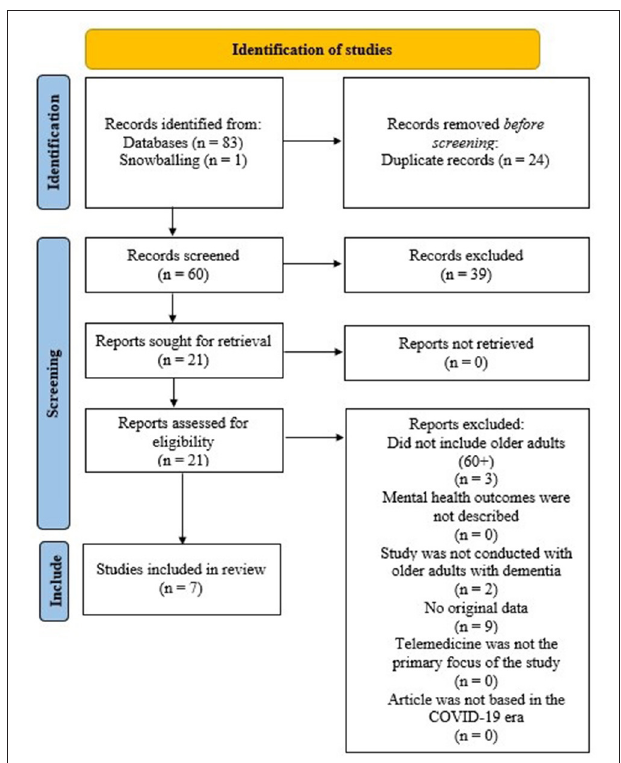
FIGURE 1 | PRISMA flow diagram illustrating the selection of the